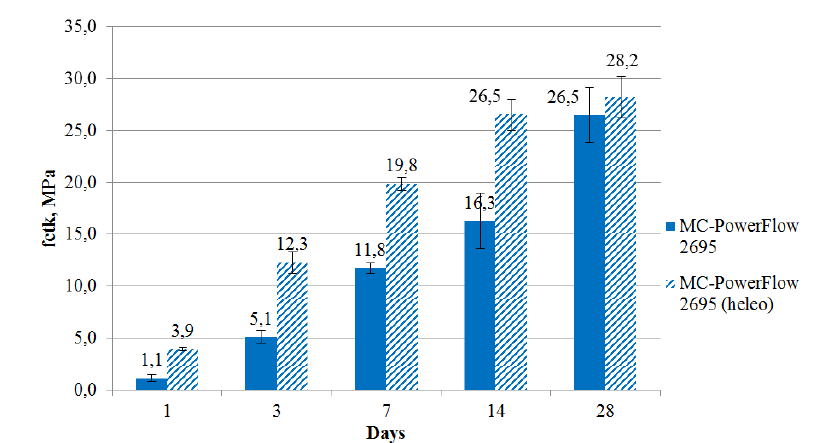
Figure 3. Comparison of concrete compressive strength versus its age depending on storage conditions using MC- PowerFlow 3100 additive.